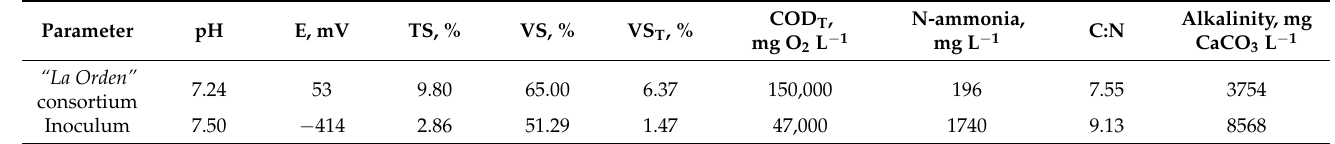
Table 7. Initial characterization of substrates used in the anaerobic digestion process.